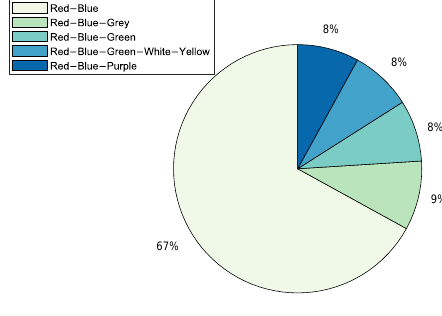
Figure 6. Cyber-Range Teams.